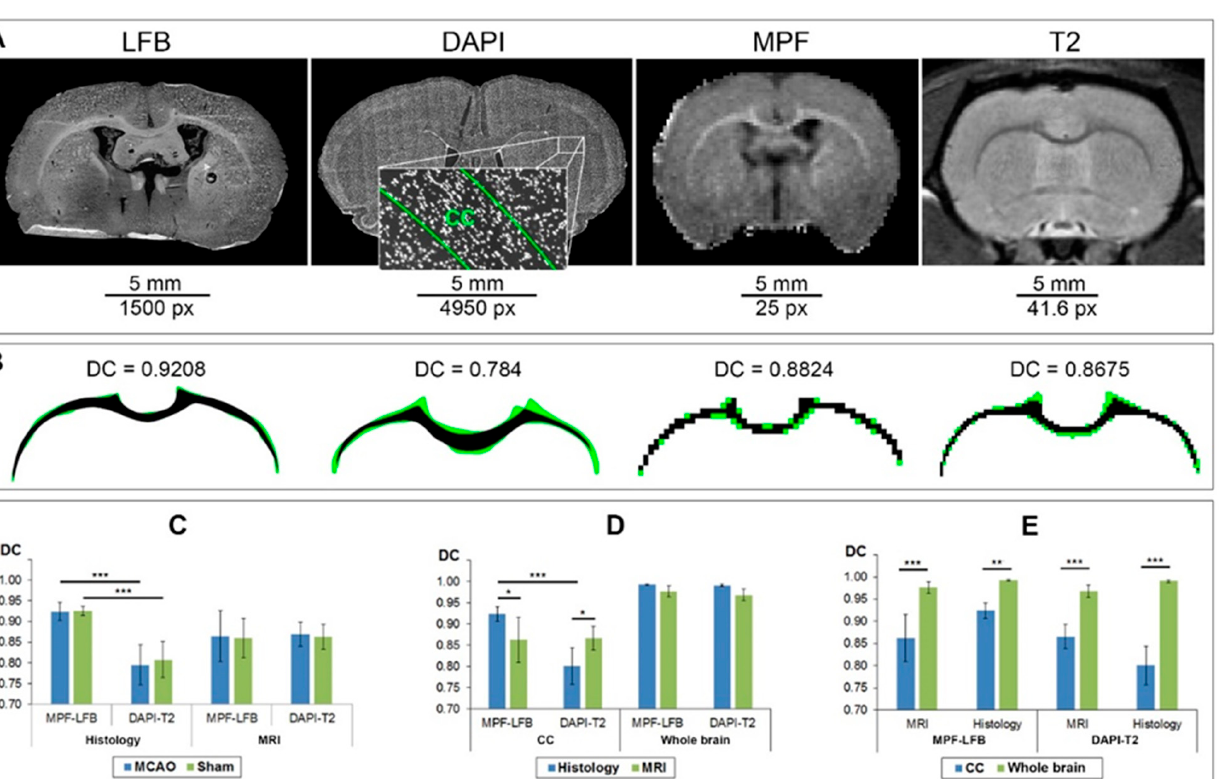
Figure 5. Correspondence between the transformed and delineated CC and brain section. ( A ) Example of ROI transformation of MR image to histological image. ( B ) Example of the ROI transformation of histological image to MR image. ( C , D ) Correspondence of the transformed and manually delineated CC and brain section in comparison with the correspondence between operators for CC ( C ) and brain section ( E ). Error bars correspond to the SD. Significant differences: * p < 0.05, ** p < 0.01, *** p < 0.001.